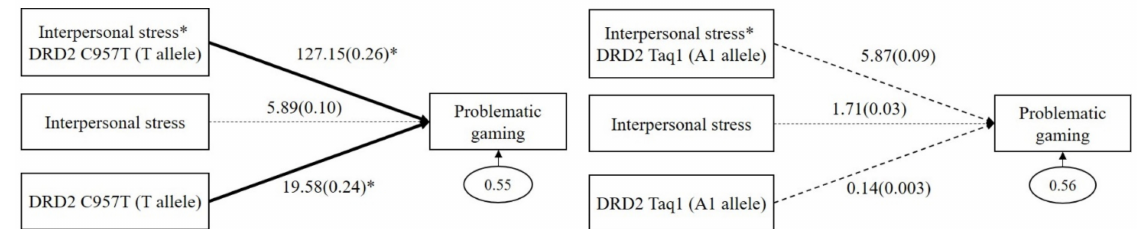
Figure 1. Interaction effect between DRD2 C957T and interpersonal stress on problematic gaming (in the left panel), and interaction effect between DRD2 Taq1 and interpersonal stress on problematic gaming (in the right panel). Sex, impulsivity, depression, anxiety, and ADHD were controlled for in all analyses (paths not shown for simplicity). Unstandardized (outside parentheses) and standardized (inside parentheses) coefficients are shown. Solid lines represent statistically significant coefficients.